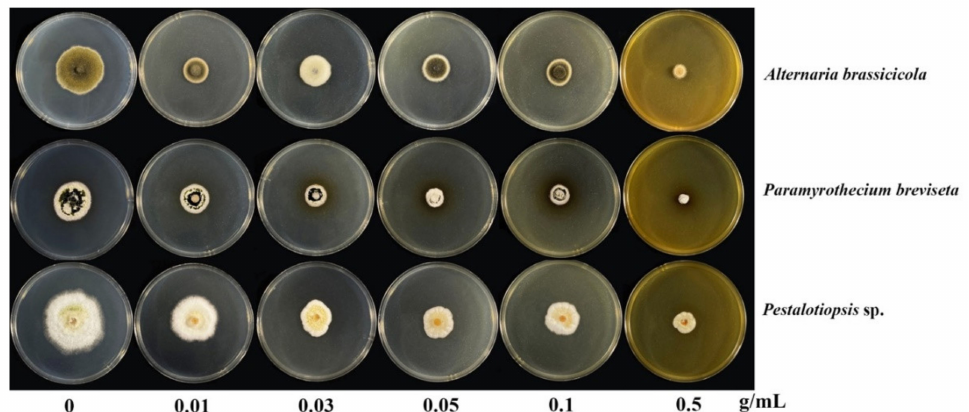
Figure 3. Inhibitory effect (inhibition zone, mm) after 7 days of inoculation of the crude methanolic fraction of coffee pulp powder against 7 days mycelium plug of Alternaria bassicicola (CRC152), Pestalotiopsis sp. (CRC151) and Paramyrothecium breviseta (CRC12). The concentrations of poison food were prepared at 0, 0.01, 0.03, 0.05, 0.1 and 0.5 g/mL extract in the potato dextrose